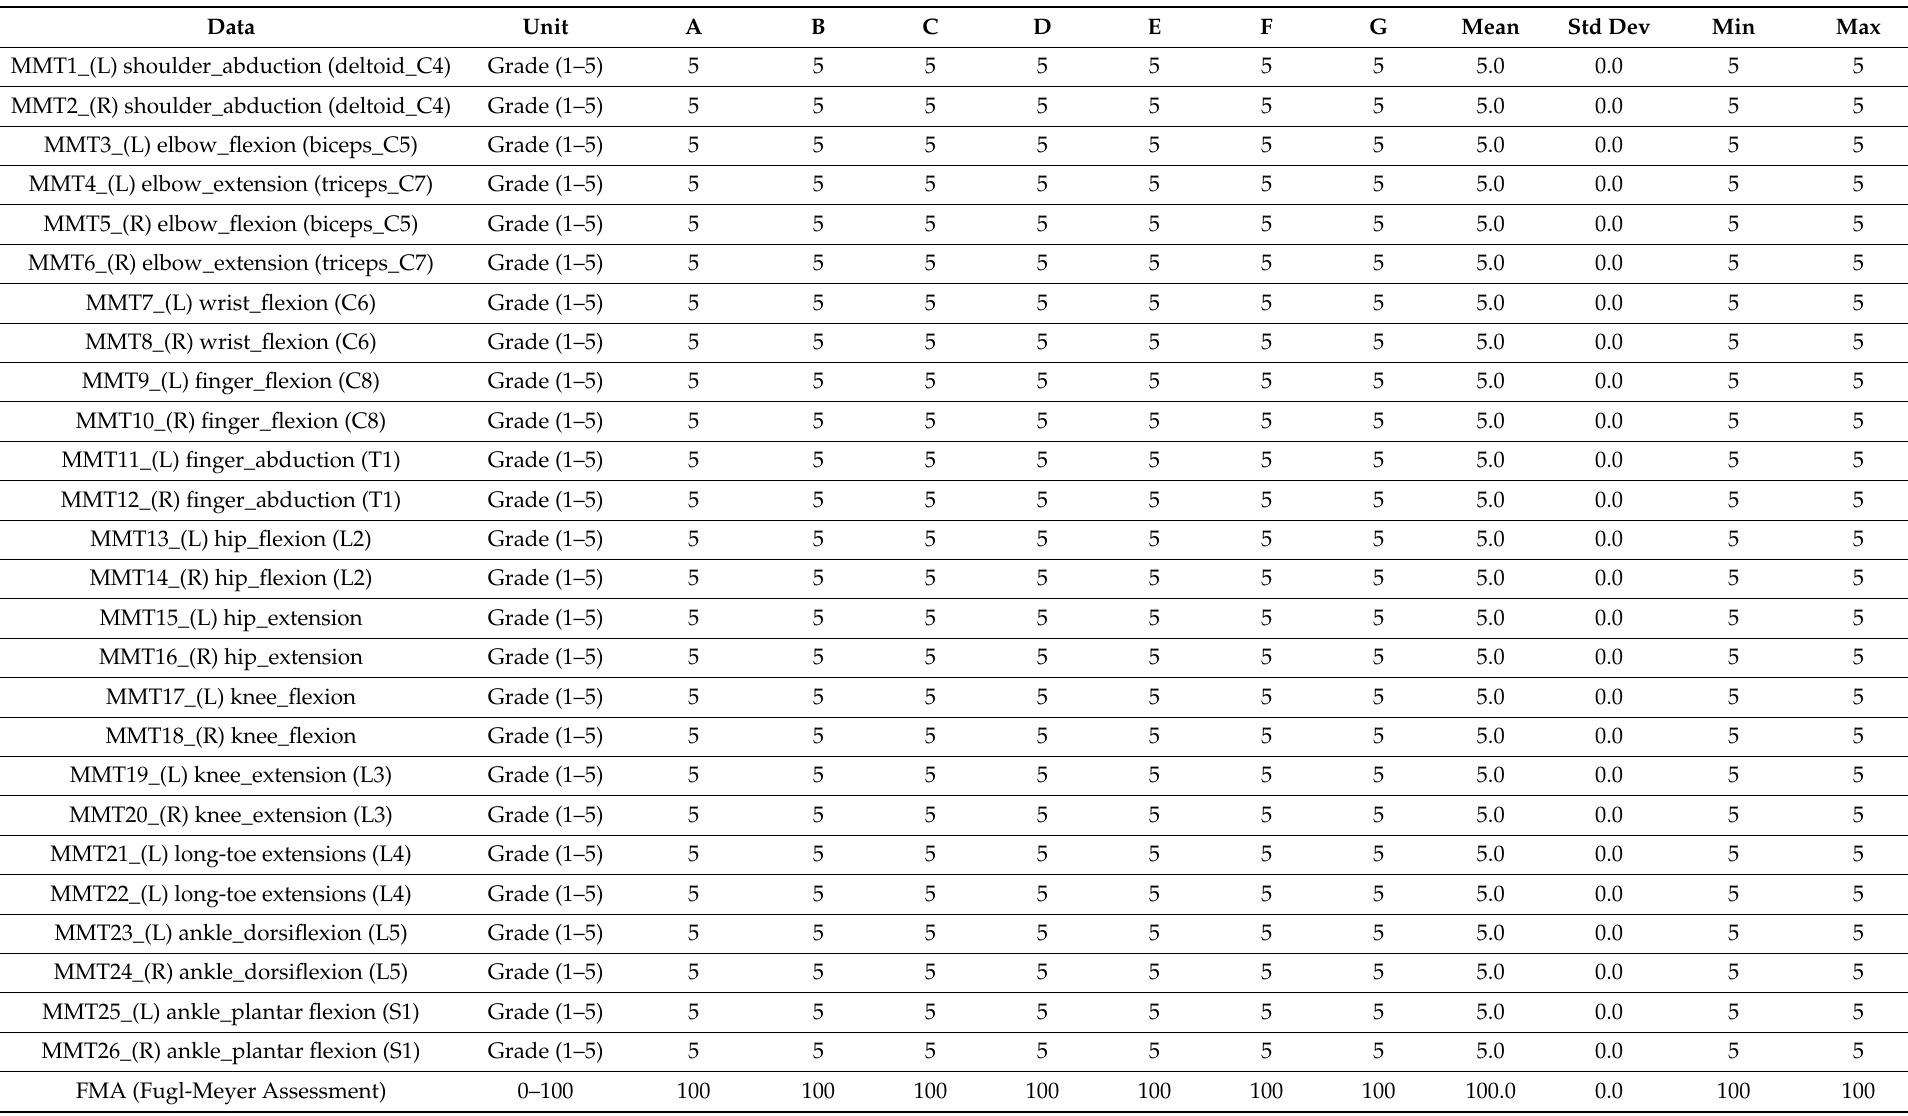
Table 3. Functioning: strength